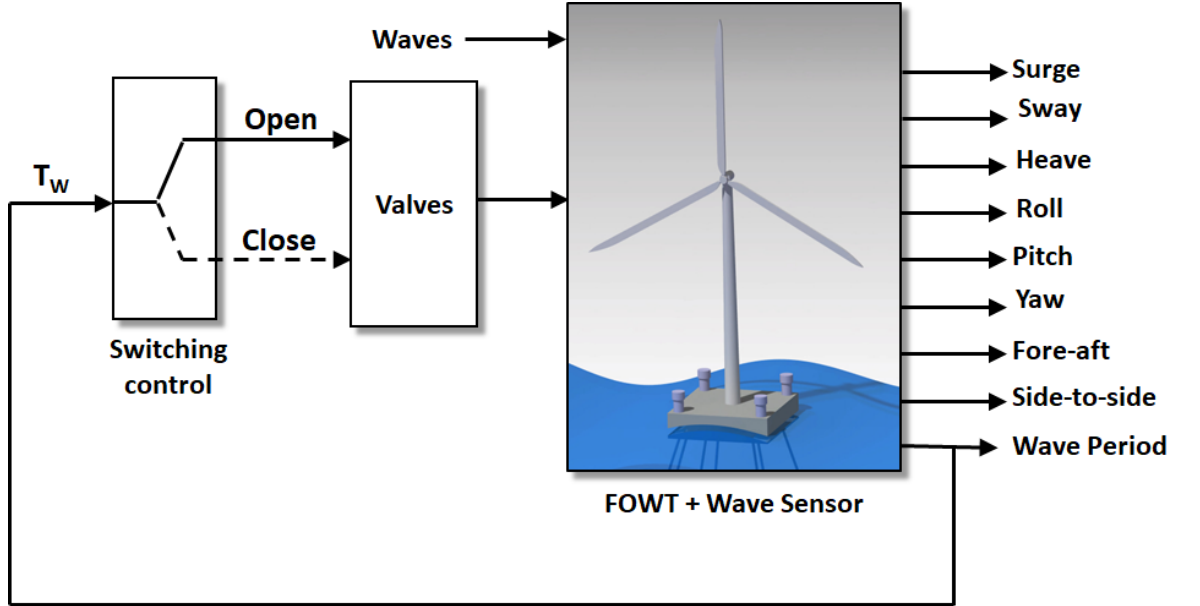
Figure 6. Block diagram of controlled